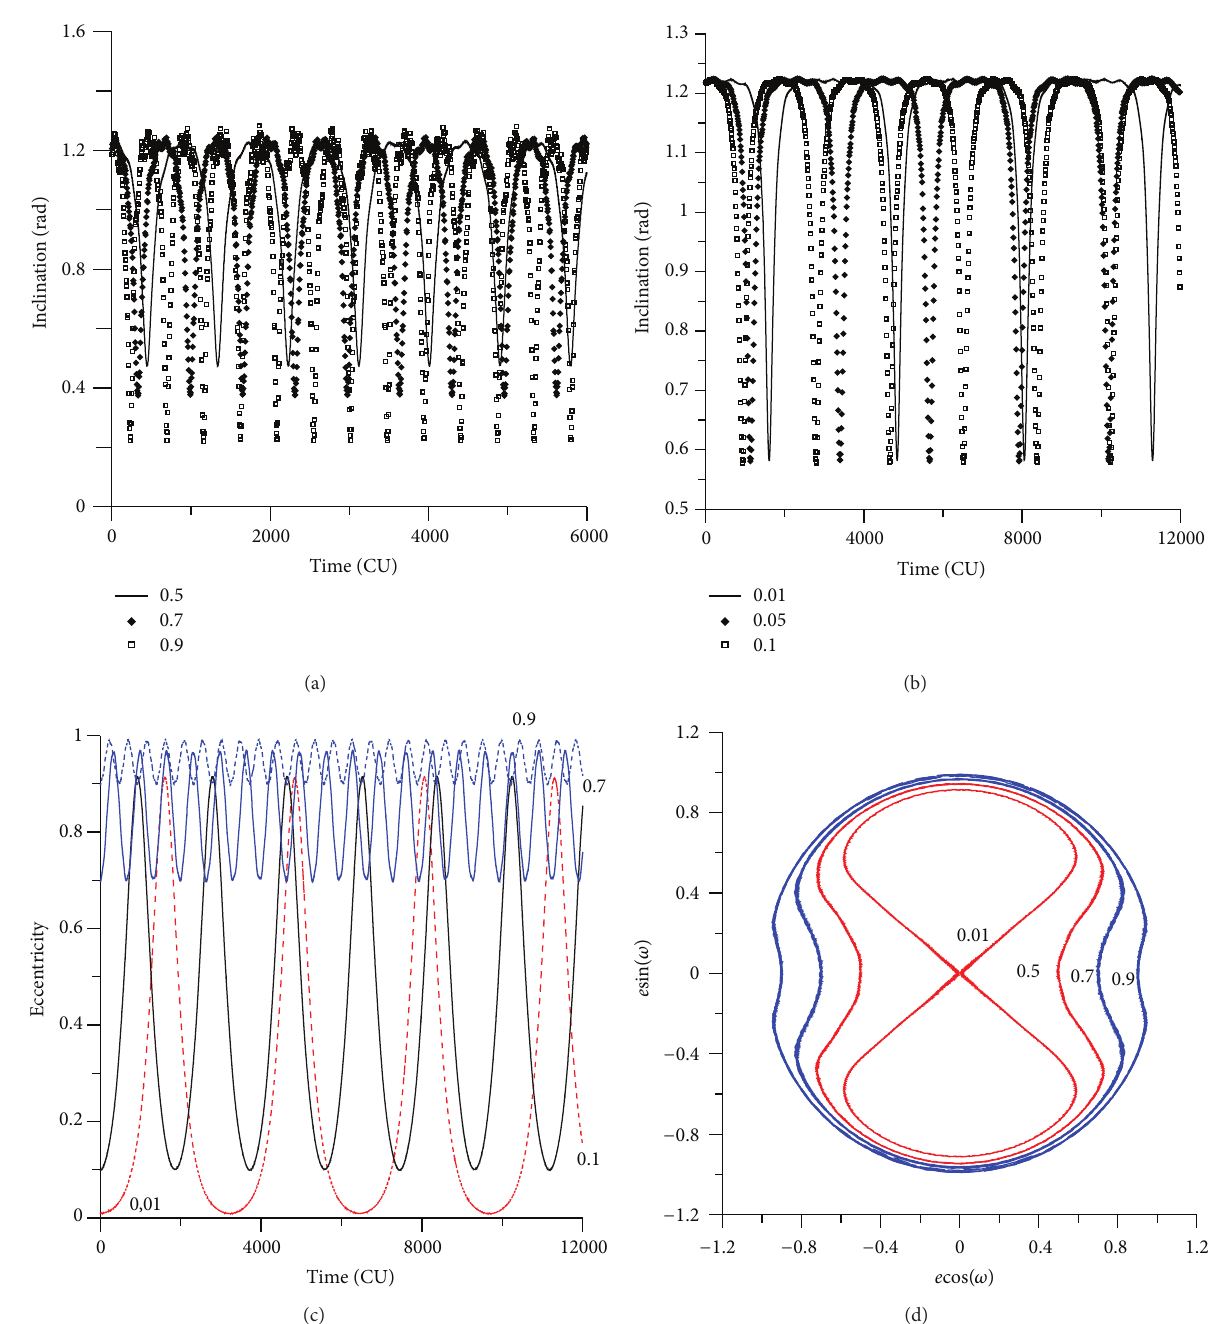
Figure 13: Behavior of the orbital elements for an initial inclination of 70 degrees. The values for the eccentricities are 0.01, 0.05, 0.10, 0.50, 0.70, and 0.90. The initial conditions are a = 0.341 canonical units, M 0 (0) = 0, 𝜔 (0) = 0, and Ω (0) = 0.